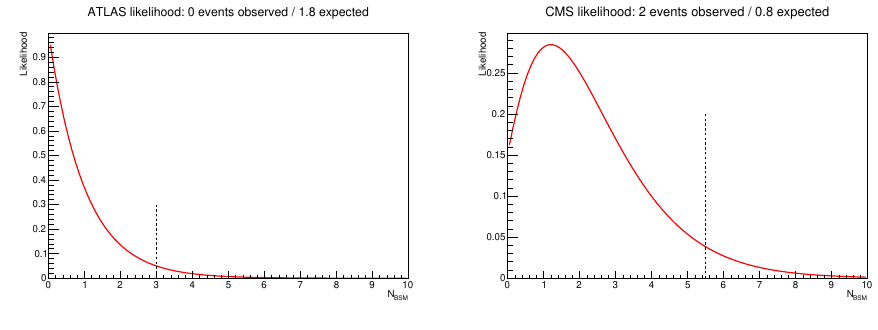
Figure 1 . ATLAS and CMS